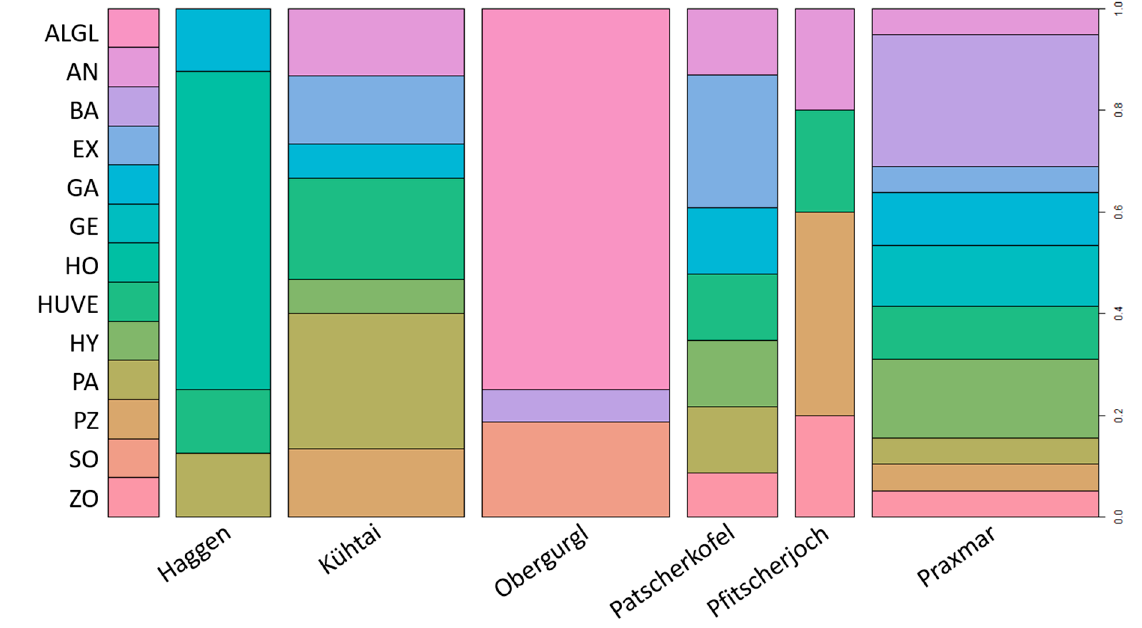
Figure 2. Overview of Mortierella s. l. isolates obtained from different locations. The percentages of different isolates (biological replicates) found in a certain sampling site are illustrated. The width of each bar corresponds to the relative sample size. Please note that the total numbers of isolates isolated from sampling sites cannot be inferred from the figure. ALGL = M. alpina/globalpina , AN = M. angusta , BA = M. bainieri , EX = L. exigua , GA = L. gamsii , GE = M. gemmifera , HO = P. horticola , HUVE = P. humilis/verticillata , HY = L. hyalina , PA = E. parvispora , PZ = M. pseudozygospora , SO = M. solitaria , ZO = M. zonata .